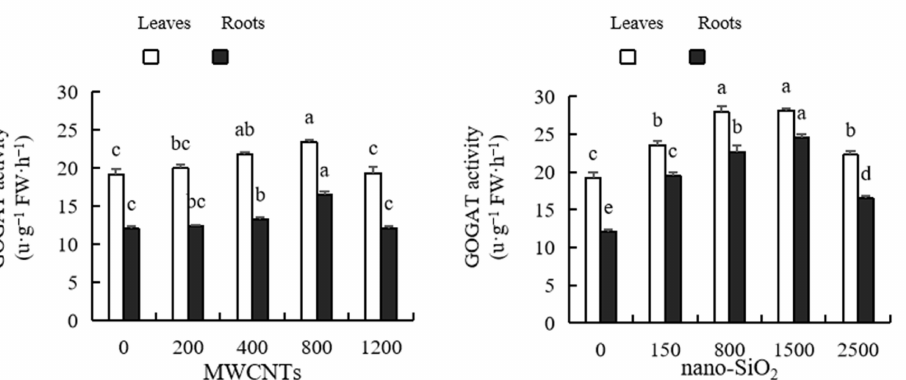
Figure 9. Effect of different concentrations of MWCNTs and nano-SiO 2 on GOGAT activity in maize. Note: Data are expressed as mean ± standard deviation. Different letters within the same column indicate significant difference at 5%